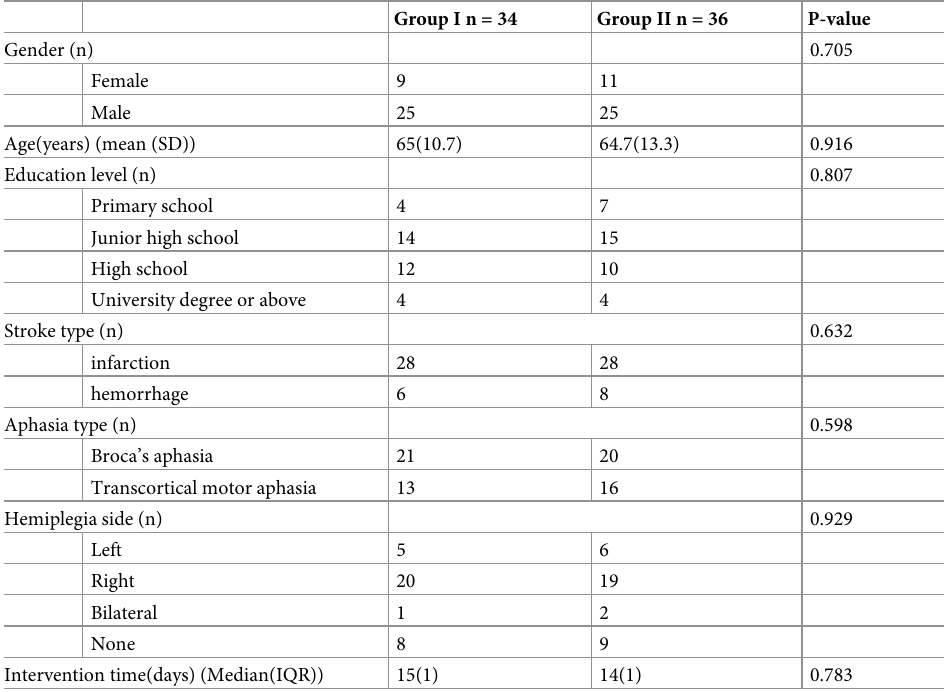
Table 1. Comparison of the two groups’ general clinical data.